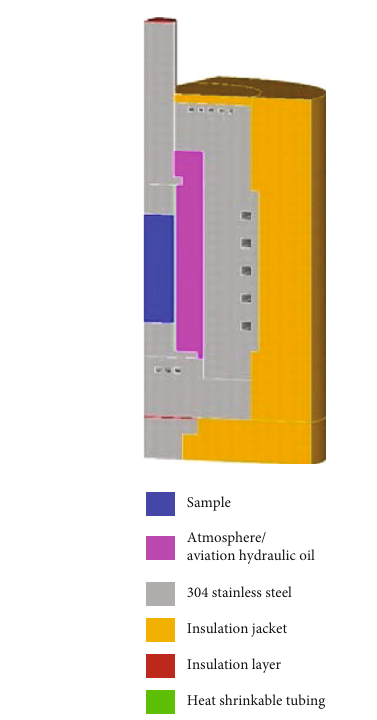
Figure 8: Finite element model of the triaxial cell and its internal